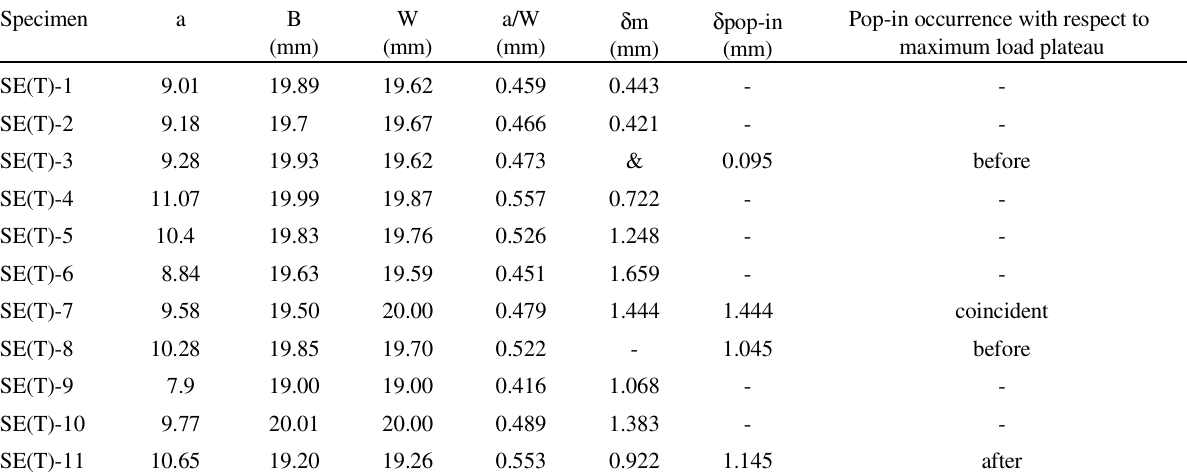
Table 6. CTOD values, tensile specimens ( SE(T) ).